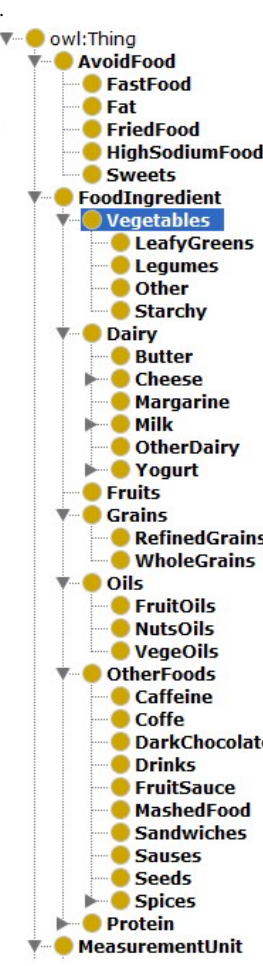
Figure 3. Part of the classes defined in the ontology used in the knowledge